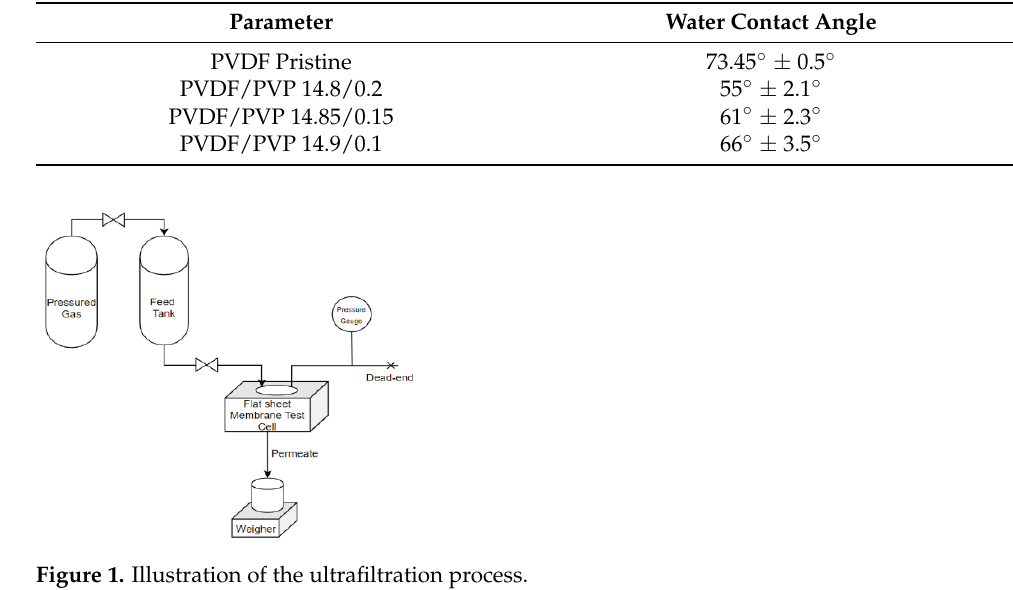
Figure 2. FTIR spectra of PVP, PVDF membranes, and PVDF membranes with various additions of PVP.